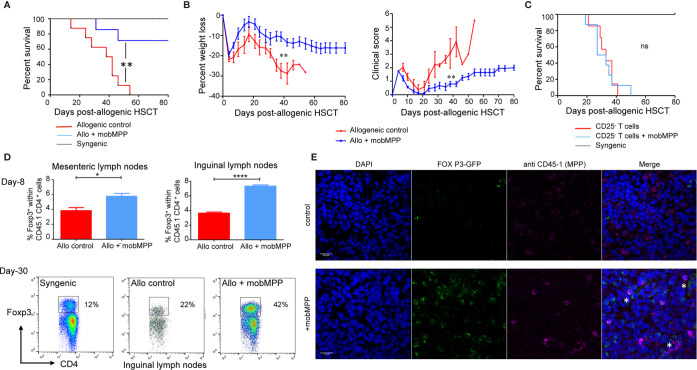
G-CSF mobilized MPP prevent GVHD by enhancing Foxp3+ Tregs in vivo. (A) Lethally irradiated (6 Gy) BALB/cJ recipients received 1 × 107 B6 T cell-depleted BM cells alone (black, n = 4) or together with 2 × 106 purified B6 T cells (allogeneic control, red, n = 7). In a third group 0.35 × 106 B6-derived mobMPP were co-transferred with the two other populations (blue, n = 7) on day 0. Less than 40% of mice having received co-transferred mobMPP died over 80 days whereas median survival was 40 days without mobMPP (**p = 0.004). Data shown represent pooled results from 2 independent experiments. Results were compared with Kaplan-Meier survival curves. (B) Mean weight loss of BALB/cJ recipients at day 40 post-HSCT (median survival group) was: -10.57 ± 2.28% in mice co-injected with mobMPP (n = 6) vs. -27.44% ± 3.60% in allogeneic controls (n = 4). Mean clinical GVHD scores in recipients at day 40 post-HSCT was: 0.8 ± 0.19 in mice co-injected with mobMPP (n = 6) vs. 3.06 ± 1.1 in allogeneic controls (n = 4). Data were compared using Student’s unpaired t-test (**p ≤ 0.01). (C) Lethally irradiated (6 Gy) BALB/cJ recipients received 1 × 107 B6 T-cell depleted BM cells alone (black, n = 4), with 2 × 106 purified CD25− B6 T cells (allogeneic control, red, n = 7) or with additional 2 × 106 purified CD25− B6 T cells and 0.35 × 106 B6-derived mobMPP (blue, n = 7). Median survival in mice having received allogeneic HSCT plus CD25− T cells was 30 days vs. 33 days in mice with co-transferred mobMPP (p = 0.52). Results were compared with Kaplan-Meier survival curves (ns, not significant). (D) Percentage of Foxp3+ Tregs in allogeneic CD45.1+CD4+ B6 T cells were studied in control BALB/c mice (red) or in BALB/c mice transplanted with mobMPP (blue) (n = 3). The percentage of Tregs in the CD45.1+CD4+ T cells in mesenteric lymph nodes were 3.84 ± 0.71% vs. 5.76 ± 0.67%, (*p=0.0274), respectively. The percentage of Tregs in the CD45.1+CD4+ T cells in inguinal lymph nodes were 3.64 ± 0.28 vs. 7.31 ± 0.29%, (****p < 0.0001, using Student’s unpaired t-test). (E) Representative confocal fluorescence micrograph of inguinal lymph nodes. BALB/c mice were sacrificed at day 15 post-allogeneic HSC and inguinal lymph nodes were harvested for confocal microscopy. Top: inguinal lymph node from control allografted BALB/c mice. Below: inguinal lymph node from allografted BALB/c mice with CD45.1 mobMPP (DAPI, blue; Foxp3, green; CD45.1 red; merged images show Foxp3/CD45.1 colocalization, indicated by *). Bar: 0.2 μm.